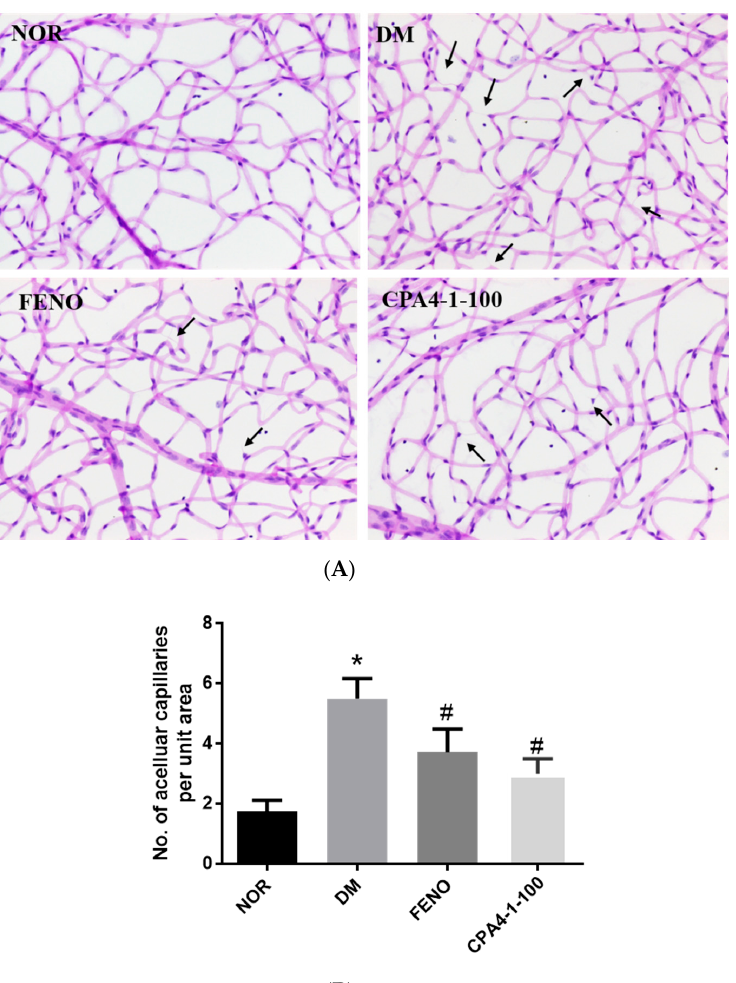
Figure 7. Effects of FENO and CPA4-1 on retinal acellular capillary formation in db/db mice. Retinal vessels were stained with H&E ( A ). Acellular capillaries (black arrow) were measured to assess the extent of retinopathy ( B ). NOR, normal control mice; DM, db/db mice; FENO, db/db mice treated with fenofibrate (100 mg/kg); CPA4-1, db/db mice treated with CPA4-1-100 (100 mg/kg). All data are expressed as mean ± SE (n = 6 ~ 7). * p < 0.05 vs. NOR group. # p < 0.05 vs. DM group.